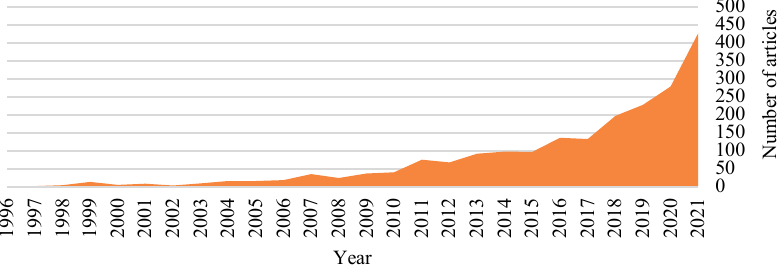
Fig. 3. Documents published per